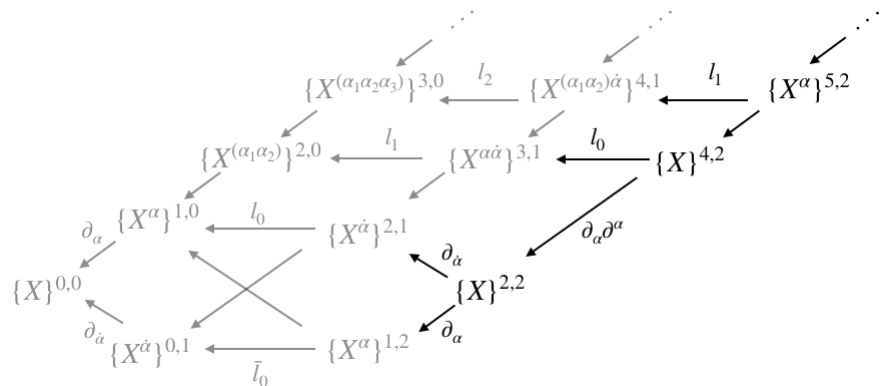
Figure 5. { X ( α 1 α 2 ··· α n − 4 ) } n, 2 ( n ≥ 2) represents the third branch and each term corrects two spaces as can be read from the diagram. The maps l n are given in the text.